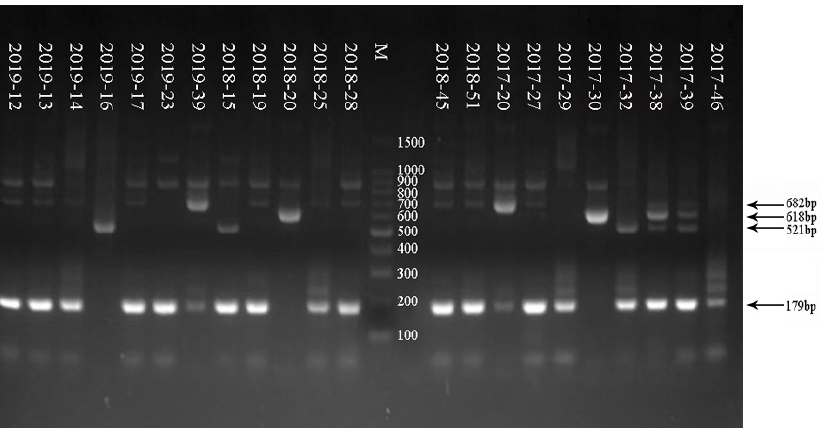
Figure 1. Electrophoretic results of Rotavirus G genotyping in some samples from 2017 to 2019.